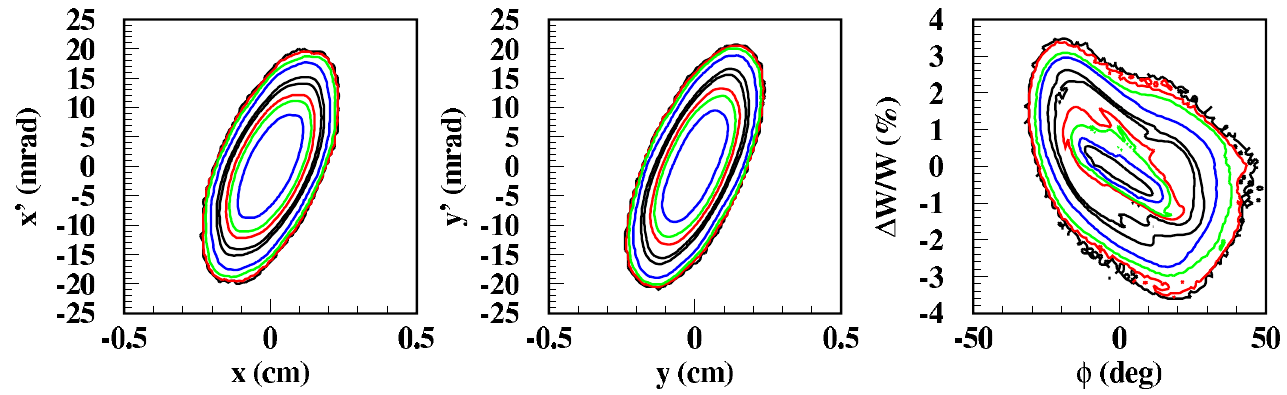
FIG. 14. (Color) Phase space contours for 10 8 particles in the three phase space planes.